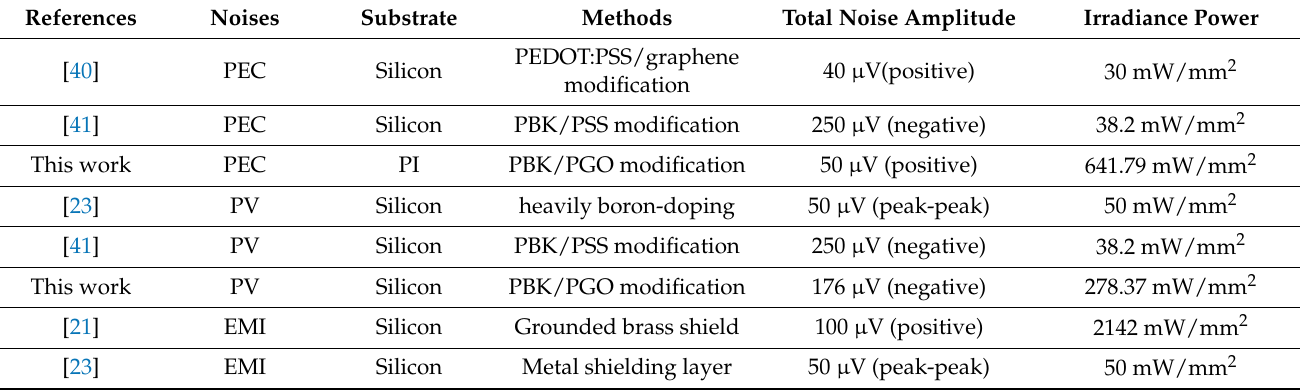
Table 2. Comparison of the reported methods for suppression of optical stimulation-induced